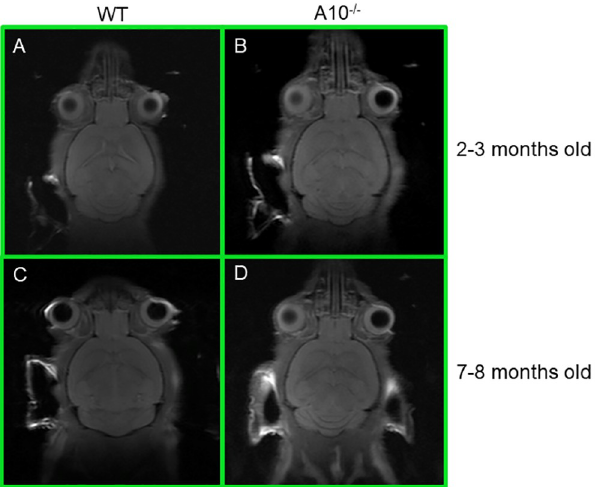
Fig 3. Micro-MRI of mouse brain. Mice were visualized using Horizontal bore 7-T MRI system, Bruker Biospin 70/30 with full vital monitoring system. (A) and (B) is the same wild type mouse at 2–3 months old and 7–8 months old, respectively, using RARE-T1 Imaging. The coronal image is whole, live, mouse brain section 11 of 15 sections. (C) and (D) is the same Acad10 -deficient mouse at 2–3 months old and 7–8 months old, respectively, using RARE-T1 Imaging. The coronal image is a representative whole, live, mouse brain section 11 of 15 sections. The Acad10 -deficient mice do not show any significant changes in brain structure and morphology over time as compared to wild type control mice of the same